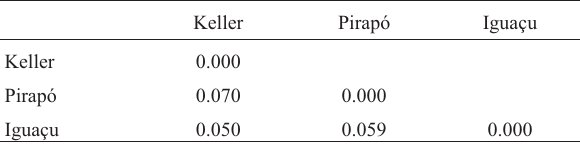
Table III - Unbiased Nei’s distances among three Astyanax altiparanae populations from the Keller and Pirapó tributaries of the Upper Paraná River basin and from the Iguaçu River, based on RAPD markers.